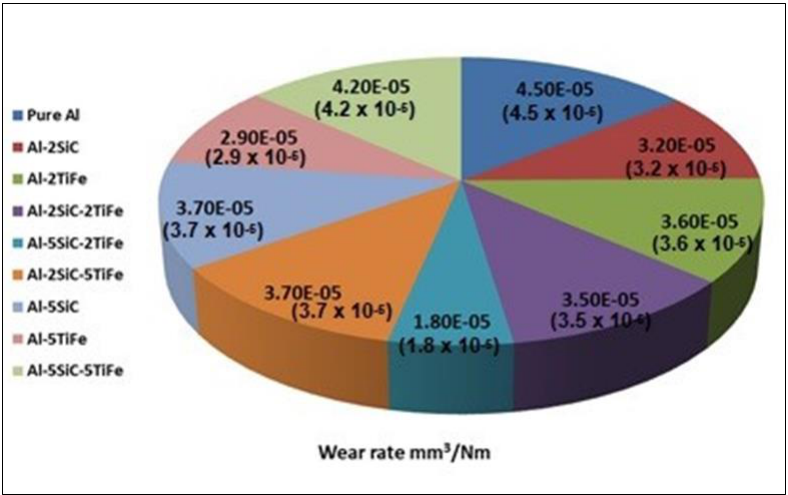
Figure 6. Wear rates of pure Al, Al-SiC, Al-TiFe and Al-SiC-TiFe composites, adapted from [135].